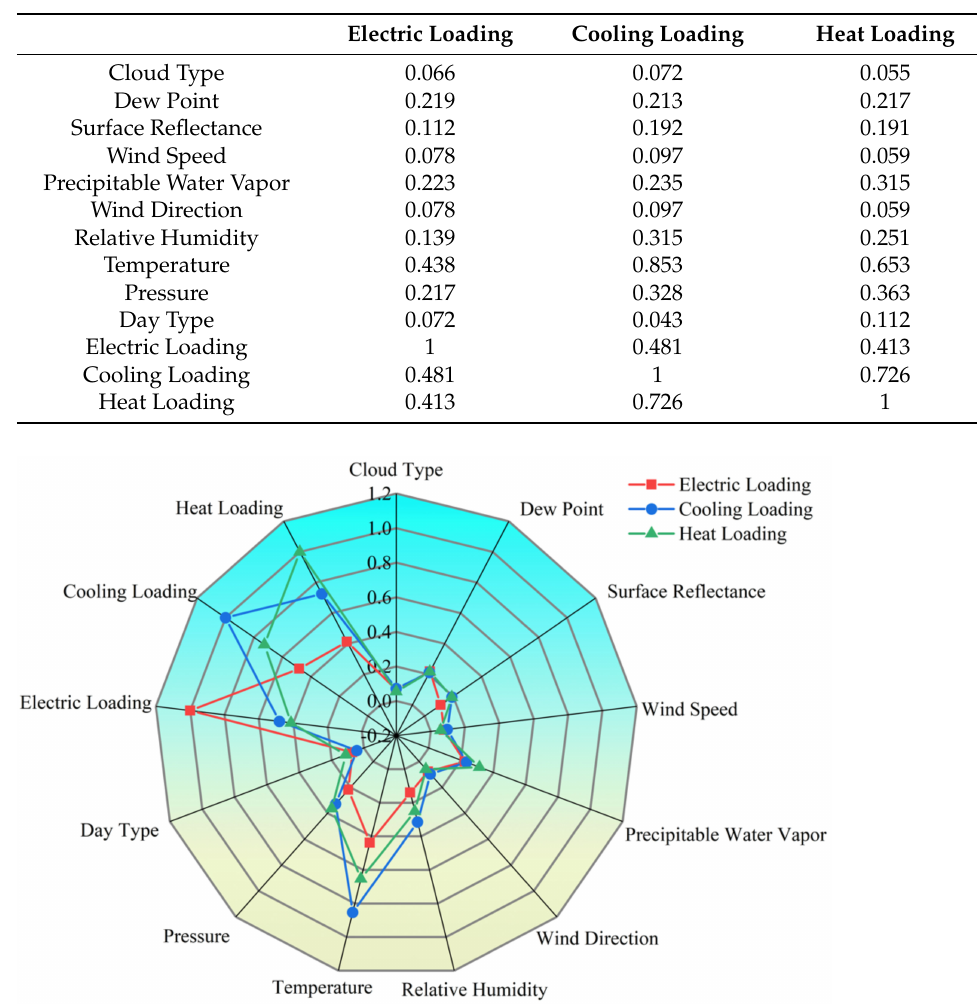
Table 3. Correlation analysis between multivariate load and characteristics.